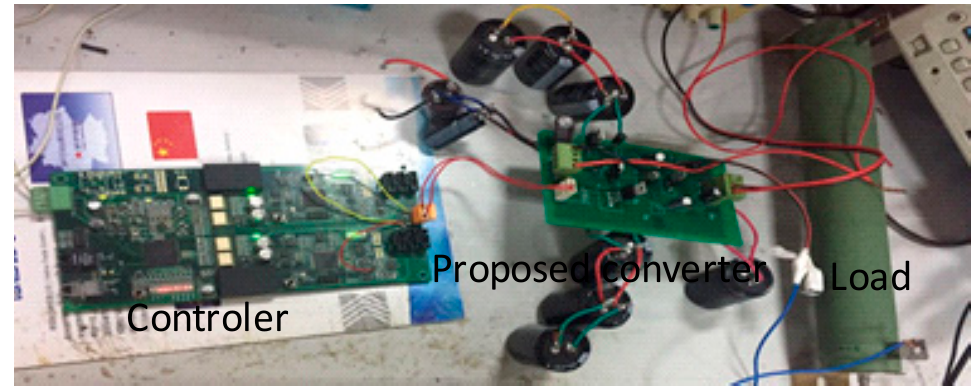
Figure 10. The prototype of the proposed converter.